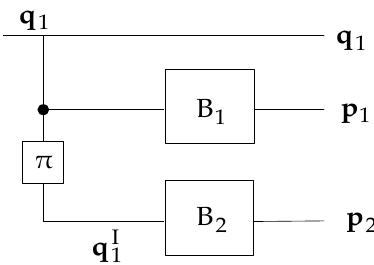
Figure 1. The concatenation of the asymmetric turbo code (ATC).